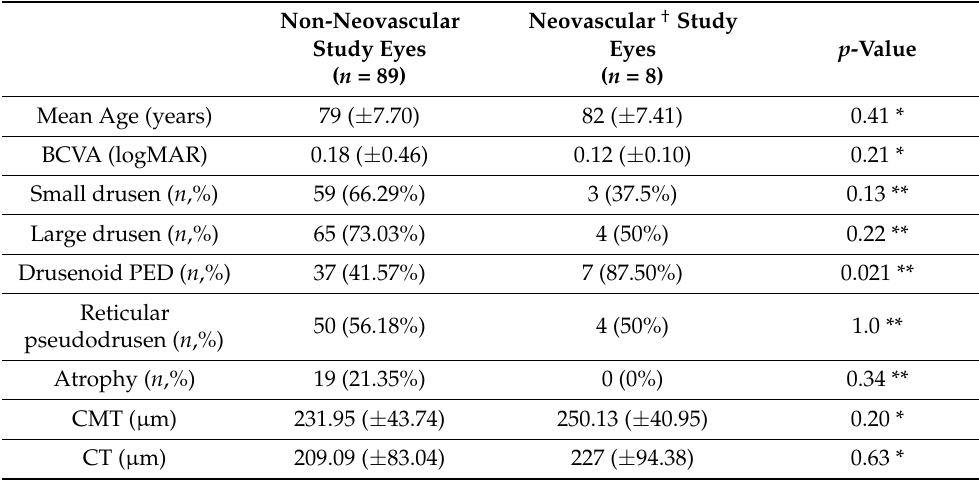
Table 2. Comparison between the non-neovascular ( n = 89) and the neovascular ( n = 8) study eyes. Non-Neovascular Neovascular † Study Eyes ( n = 89)